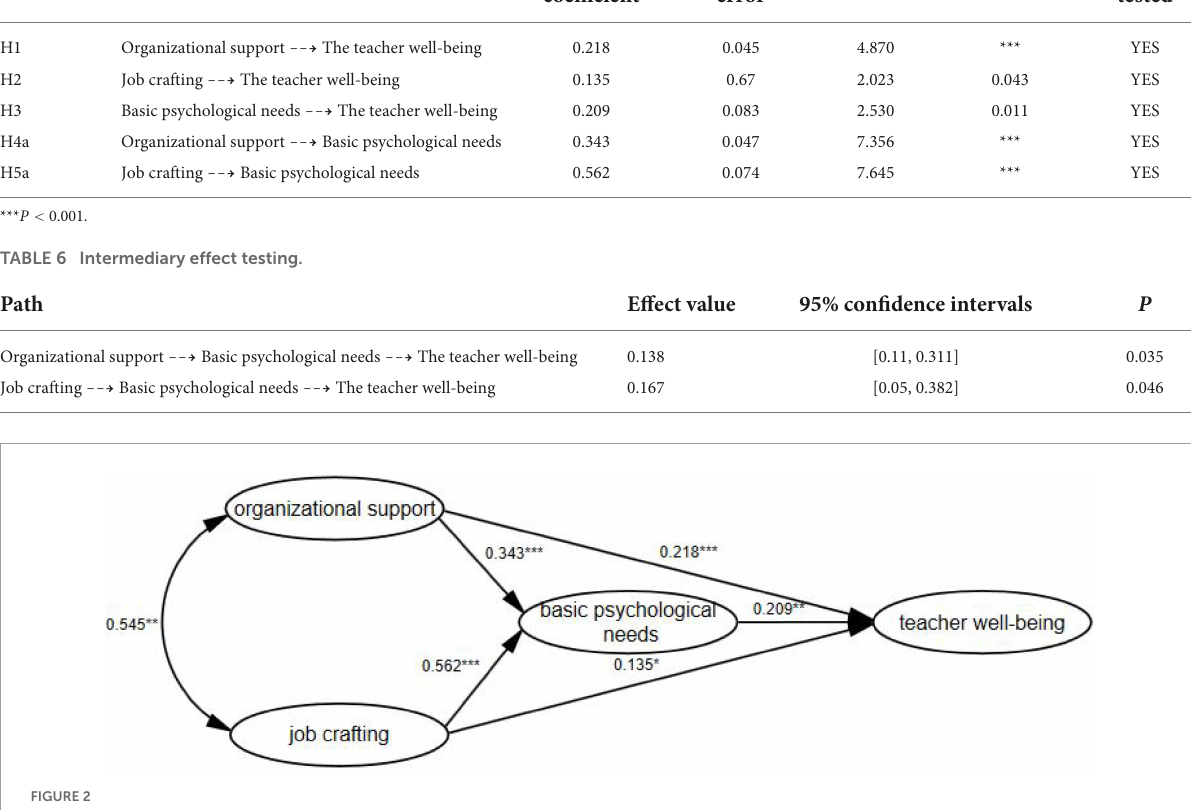
TABLE 5 Path correlation testing.